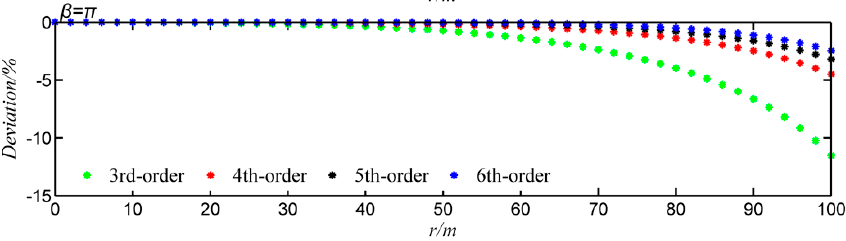
Figure 4. Deviations of high order components of Taylor series expansion.